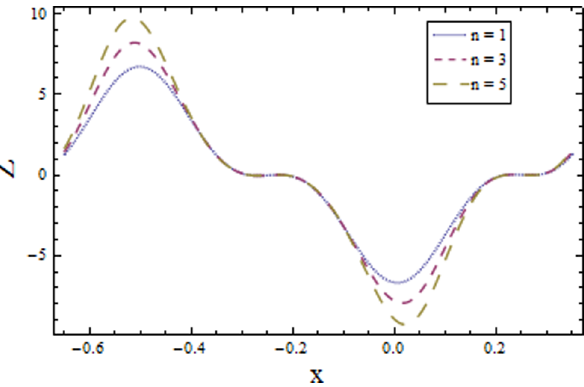
Figure 16. Plot of heat transfer coefficient Z for power law index n with E ~ 0 : 1 , t ~ 0 : 01 , ª 1 ~ 4 , ª 2 ~ 6 ,